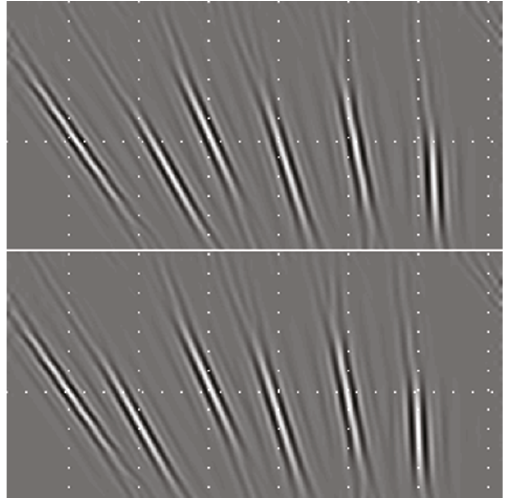
Figure 6: Six contourlet basis functions created by the PDFB without phase correction (upper part) and with phase correction (lower